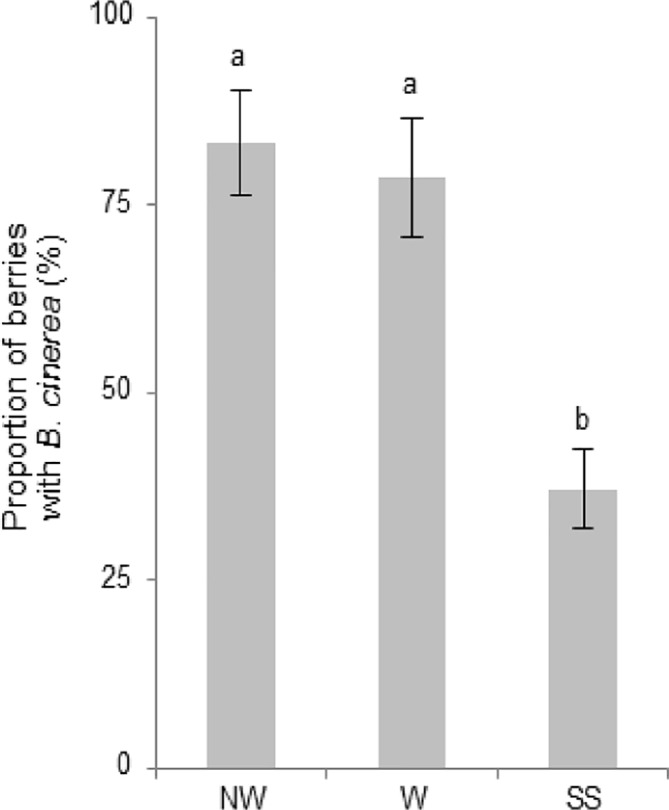
Proportion of berries showing B. cinerea at 4 wpi, following flower inoculation with the fungus, as determined by plating out. Plating out was made on selective media (PDA with Hygromycin B, 70 µg/ml) to check the presence of quiescent B. cinerea before (NW) or after washing (W), or after surface sterilization (SS). Mean proportion of berries (8–10 berries from each of six biological replicates) showing GFP-labeled B05.10 growth on the selective media. Error bars indicate standard error. Mean proportions labeled with the same letter are significantly not different, according to Tukey’s honestly significant difference test (P ≤ 0.05), using one-way ANOVA.